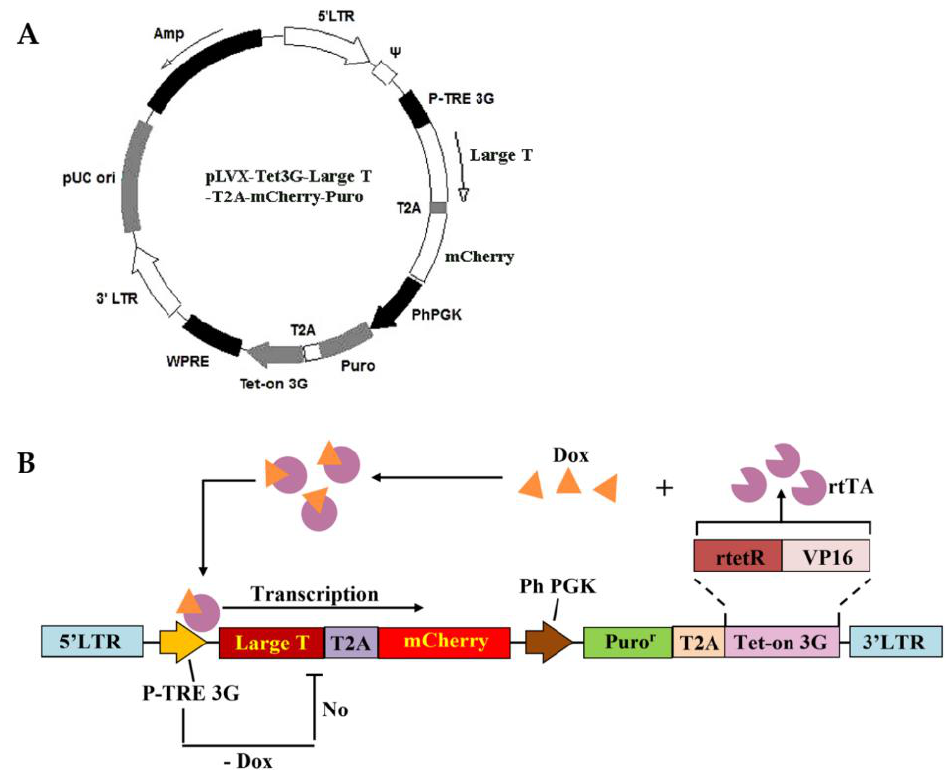
Figure 1. Lentiviral plasmid design and construction. ( A ) The lentiviral plasmid map; ( B ) the elements of the constructed plasmid: LTR, long terminal repeats sequence; P-TRE 3G, third generation Tet-inducible promoter; Large T, Simian vacuolating virus 40 Large T antigen; T2A, 2A self-cleaving peptides; mCherry, a red fluorescent protein; Ph PGK, human phosphoglycerate kinase 1 promoter; Puro r , puromycin resistance gene; Tet-on 3G (rtTA), third-generation doxycycline-responsive transactivator protein.